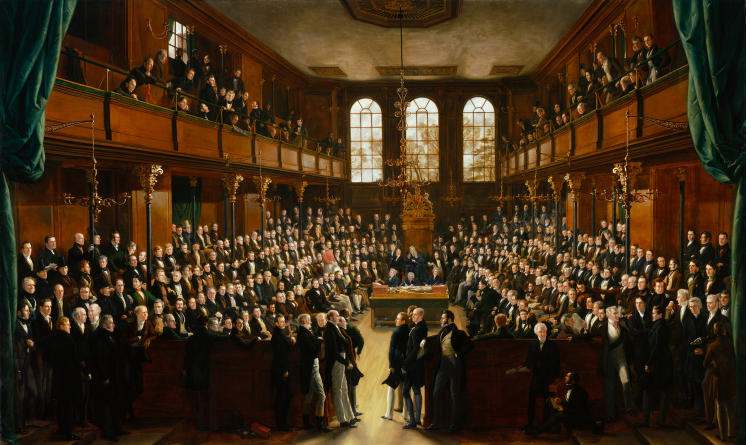
Figure 5. The House of Commons, 1833 by Sir George Hayter, oil on canvas, 1833–1843, 136 1/4 in. × 213 3/8 in. (3460 mm × 5420 mm) overall, © National Portrait Gallery, London